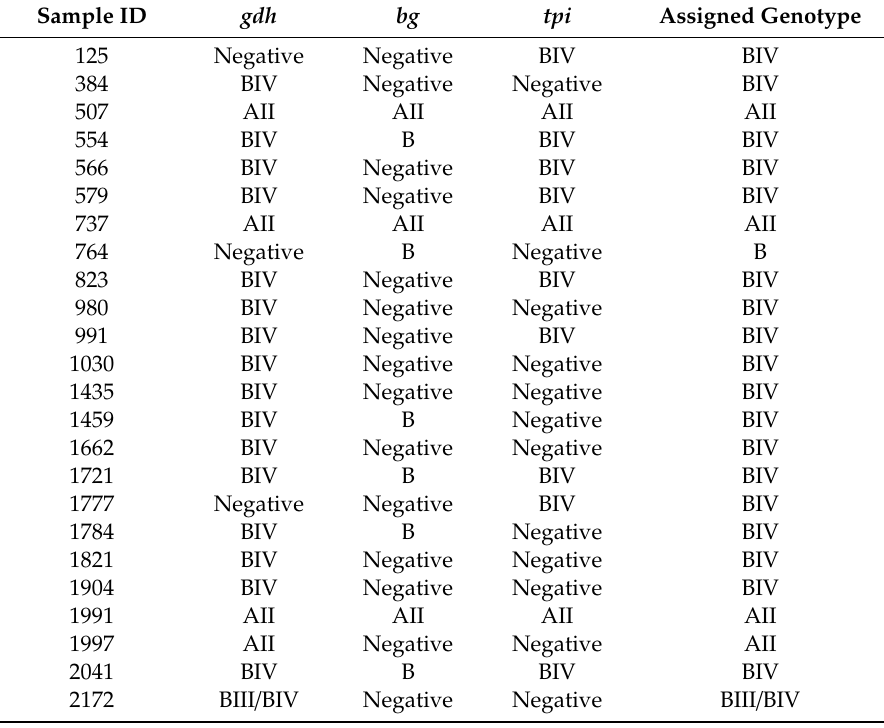
Table 2. Genotyping results of Giardia duodenalis sequences at the gdh , bg and tpi loci obtained in the children population under study in Legan é s, Madrid,